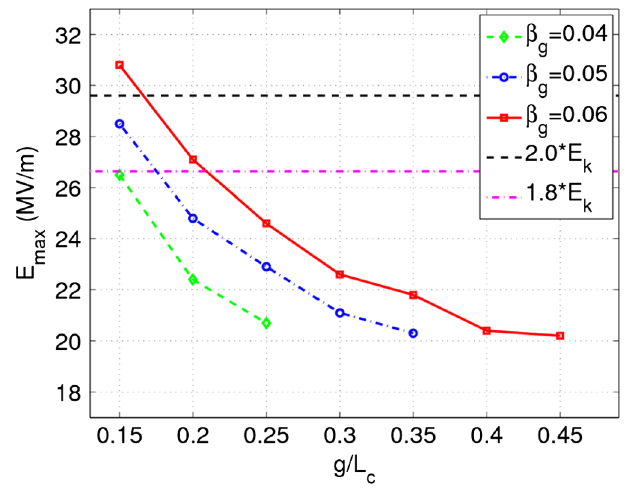
) versus the beam FIG. 6. Maximal electric field in the IH structures with vanes g versus the relative width of the gap between